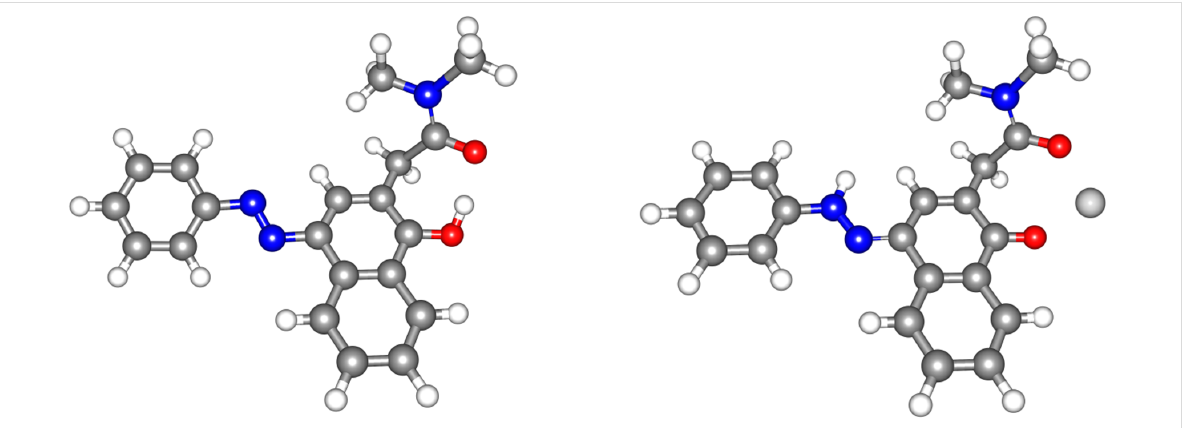
Figure 1: The most stable tautomeric form of 6 in neutral state (left) and upon complexation with Mg(ClO 4 ) 2 (right).